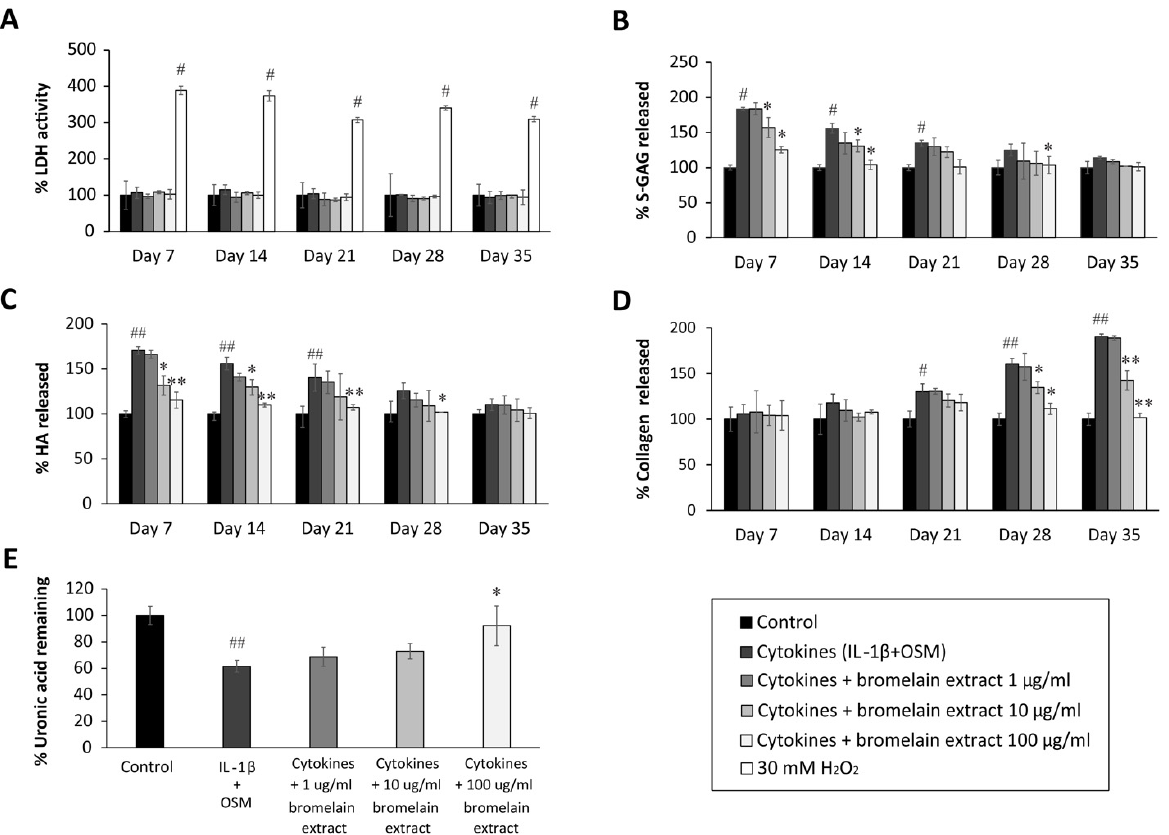
Figure 2. Effect of bromelain extract on the release of glycosaminoglycan release and matrix uronic acid content in porcine explants treated with cytokines (IL ‐ 1 β /OSM) for 35 days. The culture medium was collected on days 0, 7, 14, 21, 28, and 35 from each group, and cartilage discs on day 35 were digested with 10 U of papain. The LDH activity in culture medium ( A ) was analyzed to determine the toxicity of bromelain compared with H2O2 treatment. The levels of s ‐ GAG ( B ), HA ( C ), collagen released into culture medium ( D ), and uronic acid remaining in cartilage tissue ( E ) were measured and calculated as the percent change versus control. Each value is expressed as the mean ± SD. # p < 0.05 compared with control, * p < 0.05 compared with IL ‐ 1 β treatment alone.